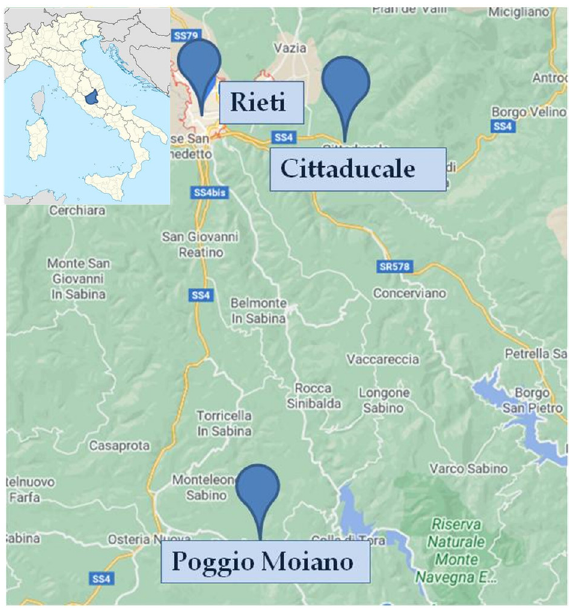
Figure 1. Map of the three sampling sites in the study area (province of Rieti, central Italy).